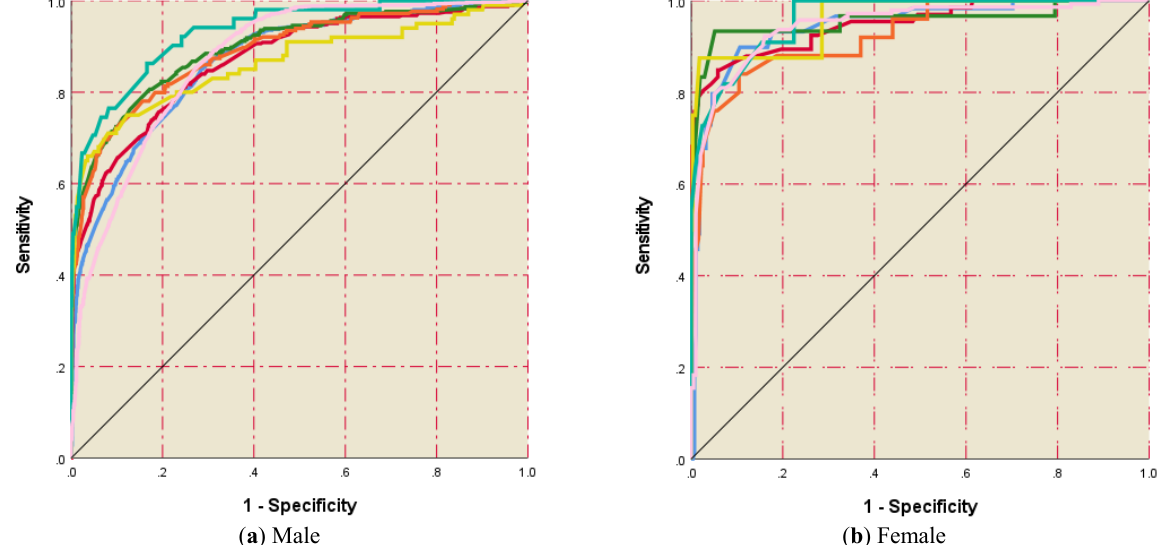
Figure 4. The ROC curve for each output variable of: ( a ) male, ( b ) female.